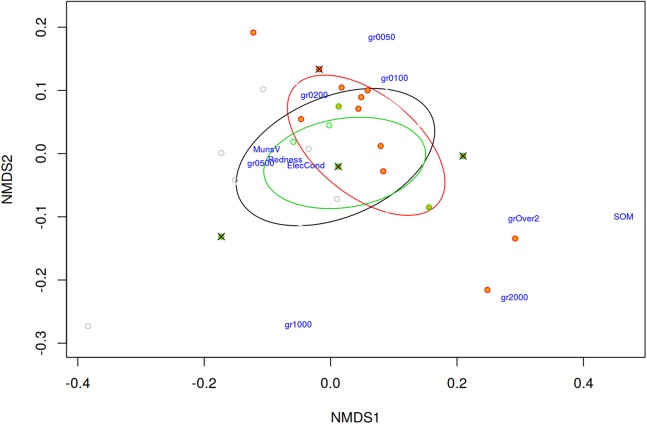
Non-metric multidimensional scaling (NMDS) for soil variables represented by pairwise Bray–Curtis distances between quadrats (stress = 0.0562).Orange filled points represent quadrats with the presence of diploid C. aspera, green with allotetraploid C. seridis, crosses with triploid hybrids, and empty circles quadrats with absence of Centaurea. Ellipses represent standard deviations for the three species. Analysis was performed in “El Saler North” site. gr2000, percentage of particles measuring between 1 and 2 mm in diameter; gr1000, percentage between 0.5 and 1 mm; gr0500, percentage less between 0.2 and 0.5 mm; gr0200, percentage between 0.1 and 0.2 mm; gr0100, percentage between 0.05 and 0.1 mm; gr0050, percentage <0.05 mm; MunsV, Munsell Value; SOM, soil organic matter; ElecCond, electrical conductivity.